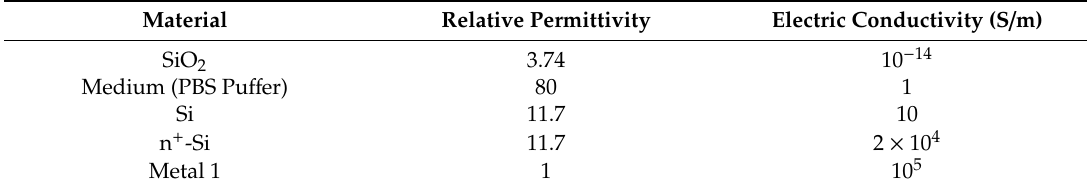
Table 1. Material properties used in finite element